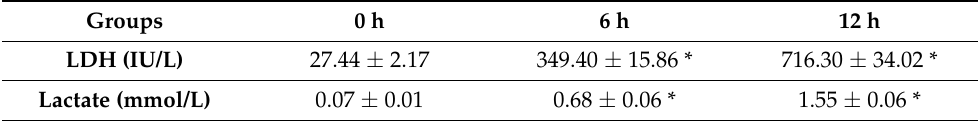
Table 2. Biochemical analysis of preservation fluid.